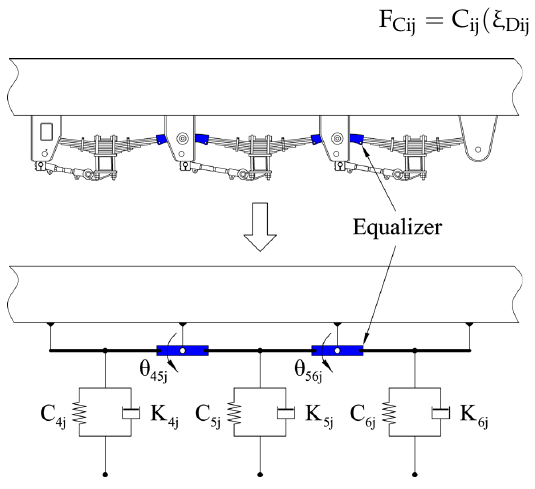
Figure 2. Suspension model of the semi-trailer using the leaf spring.